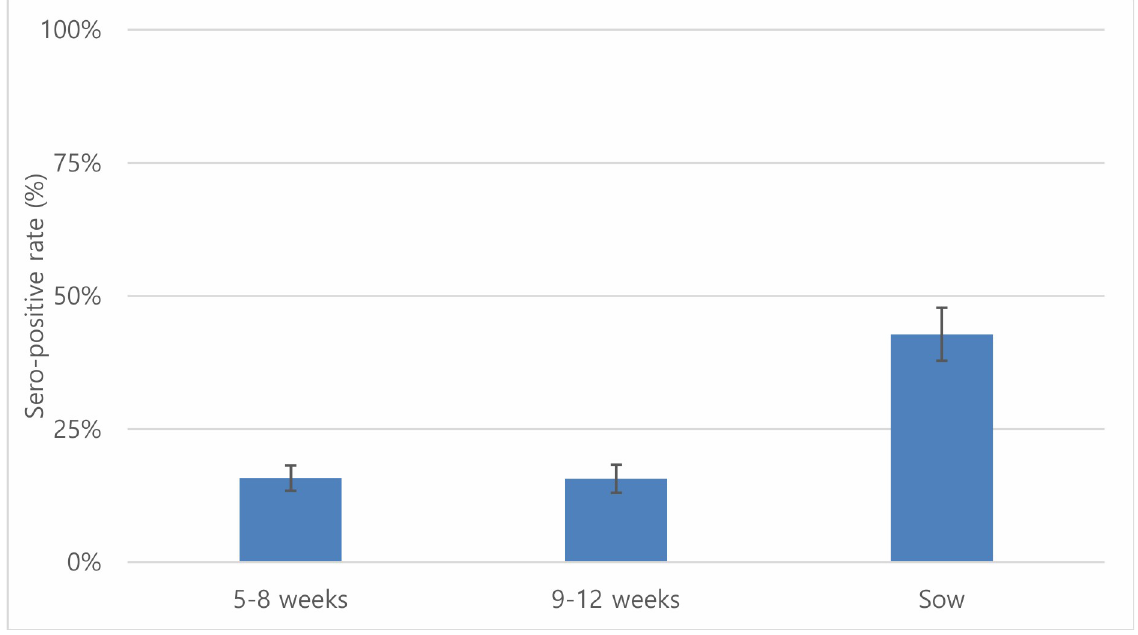
Fig 3. Seropositive rates of leptospirosis with 95% confidence interval by age group in pigs using cut off titer � 1:100.